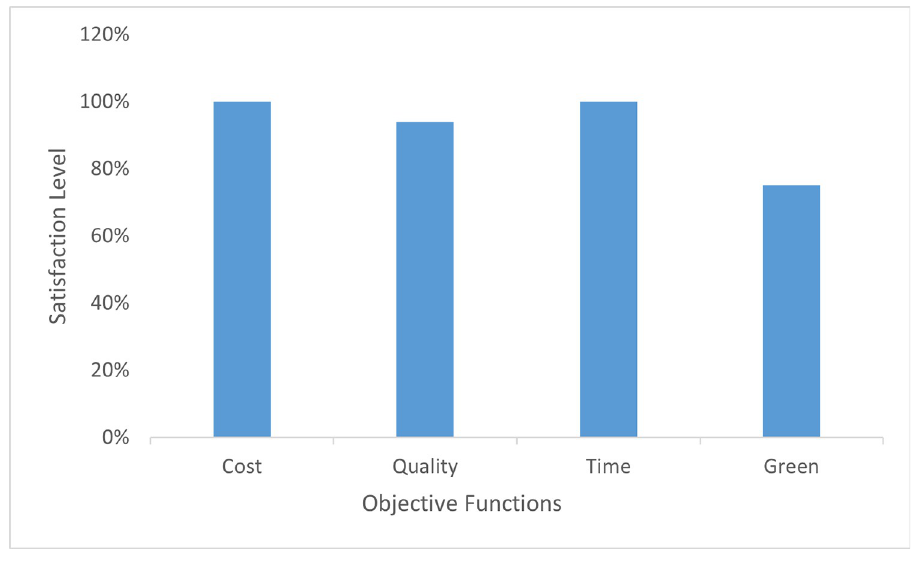
Fig 2. Achieved satisfaction